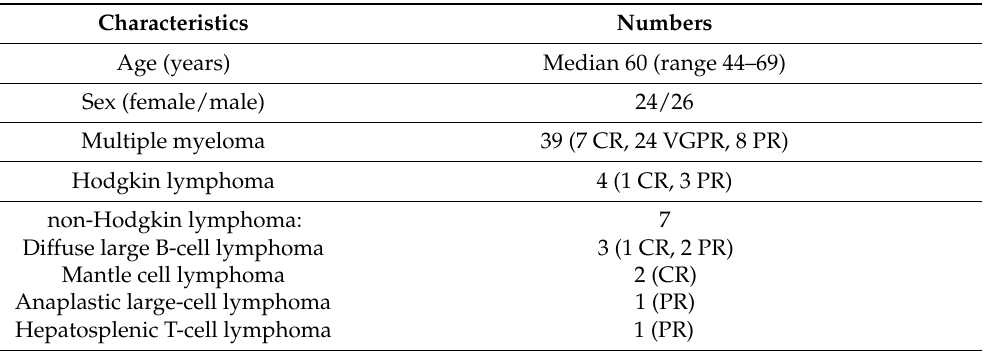
Table 1. Characteristics of the patients enrolled in the